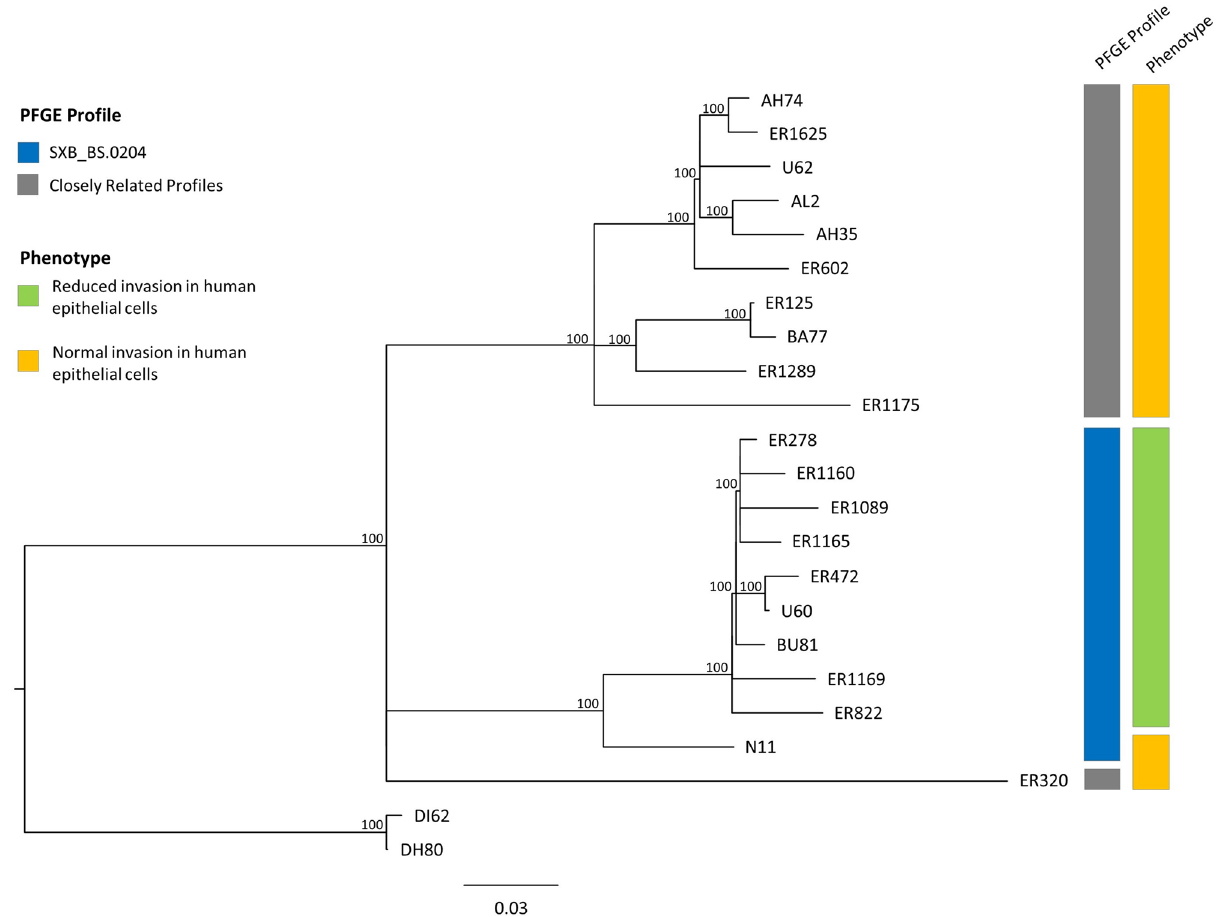
Figure 2. Maximum-likelihood phylogenetic tree of representative S . Derby isolates of the study. PFGE type and the virulence phenotype are shown in the filled boxes as indicated in the embedded key. Isolates DI62 and DH80 (SXB_PR.0072 profile) were selected as outgroup. Bootstrap values of the nodes are reported when >